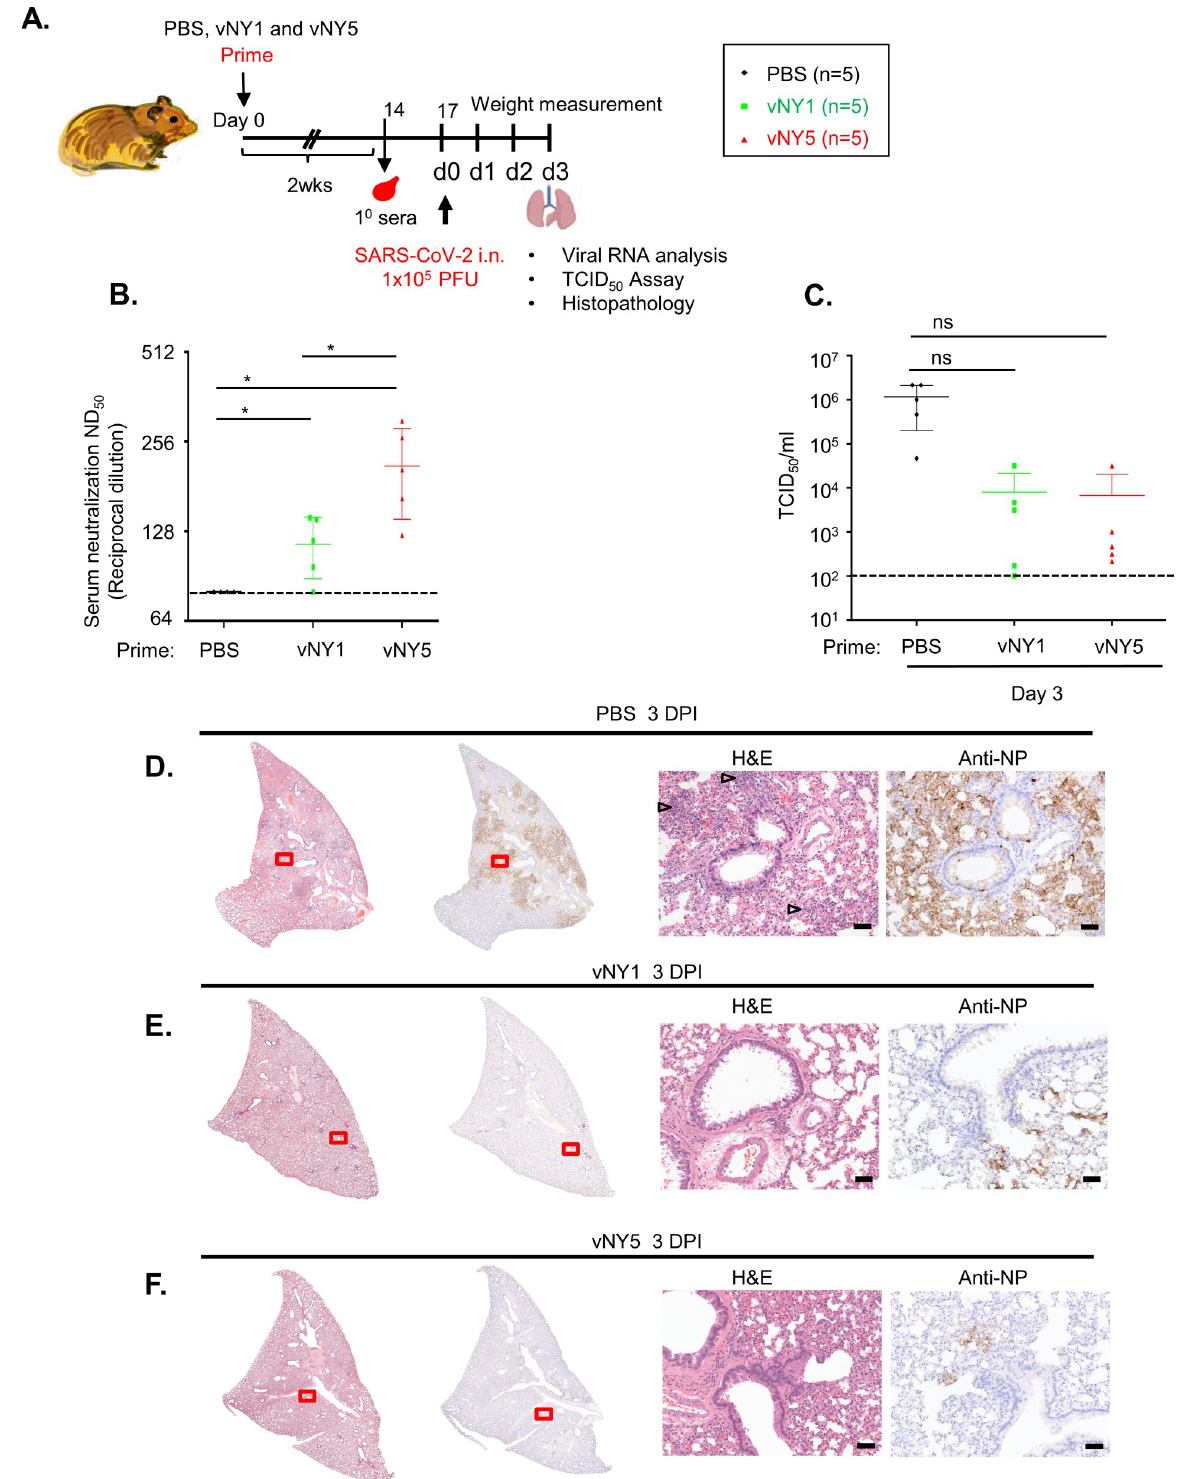
Fig 7. Single-dose vNY1 or vNY5 vaccination partially protected hamsters from intranasally-administered SARS-CoV-2 infection. (A). Timeline showing the immunization and challenge experiment. Hamsters immunized with a single dose of vNY1, vNY5 or placebo (PBS) were challenged i.n. with 1x10 5 PFU SARS-CoV-2 virus and then lungs were harvested at 3 d.p.i.. (B). Pseudovirus neutralization assays of the 1˚ sera collected 2 weeks after vaccine priming in hamsters. PBS control (n = 4); vNY1 (n = 5); and vNY5 (n = 5). Data represented as mean ± SD. The